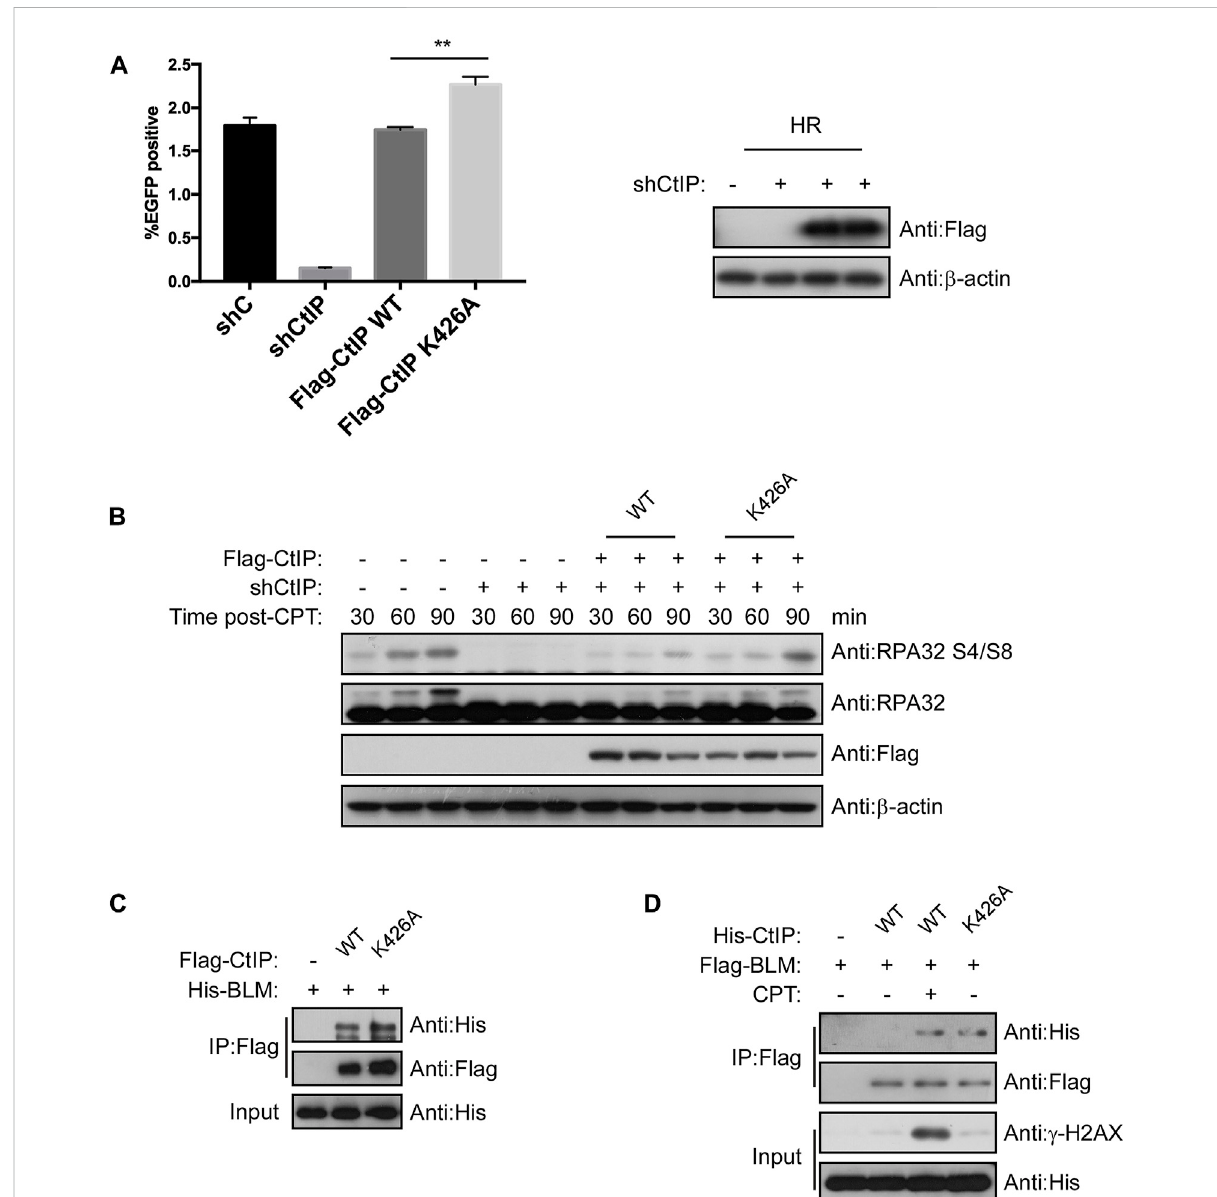
FIGURE 7 Ubiquitination of CtIP by PPIL2 suppresses HR and DSB end resection. (A) An EGFP-HR assay was performed in U2OS cells stably expressing Flag-CtIP WT or K424A mutant, and U2OS cells were infected with an shRNA control (shC) or shPPIL2. Western blotting shows the expression of Flag-CtIP variants. (B) U2OS cells were transfected to stably express Flag-CtIP WT or K426A mutants and treated with shCtiP to silence endogenous CtIP expression, treated with CPT (2 μ M) for 1 h and released at different times, and then assayed via Western blotting with the indicated antibodies. (C) IPandWesternblottingwiththeindicatedantibodiesoflysatefrom293TcellswerecotransfectedwithHis-BLMandFlag-CtIPmutant expression constructs. (D) 293T cells were cotransfected with Flag-BLM and His-CtIP mutant expression constructs. Cells were treated with